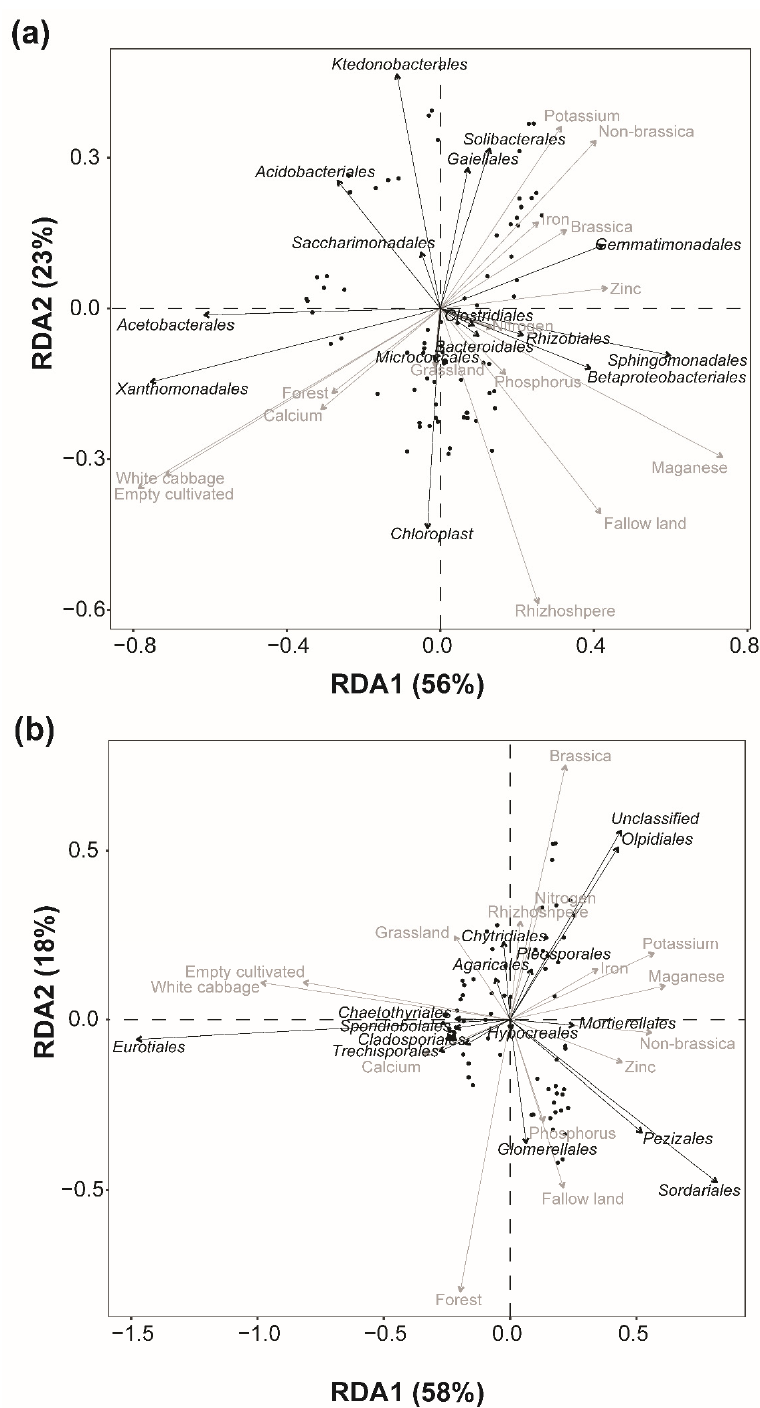
Figure 5. Redundancy analysis (RDA), illustrating the effects of landscape factors, soil physical–chemical properties, soil fraction, and crop type (arrows) on ( a ) soil bacterial orders and ( b ) soil fungal orders. The length and orientation of the arrows show the amount of variance that the explanatory and response variables can explain. The correlations between soil bacterial and fungal classes and explanatory variables are represented by the perpendicular distance between them (<90 ◦ = positive correlation, >90 ◦ = negative correlation). The strong association is represented by a smaller perpendicular